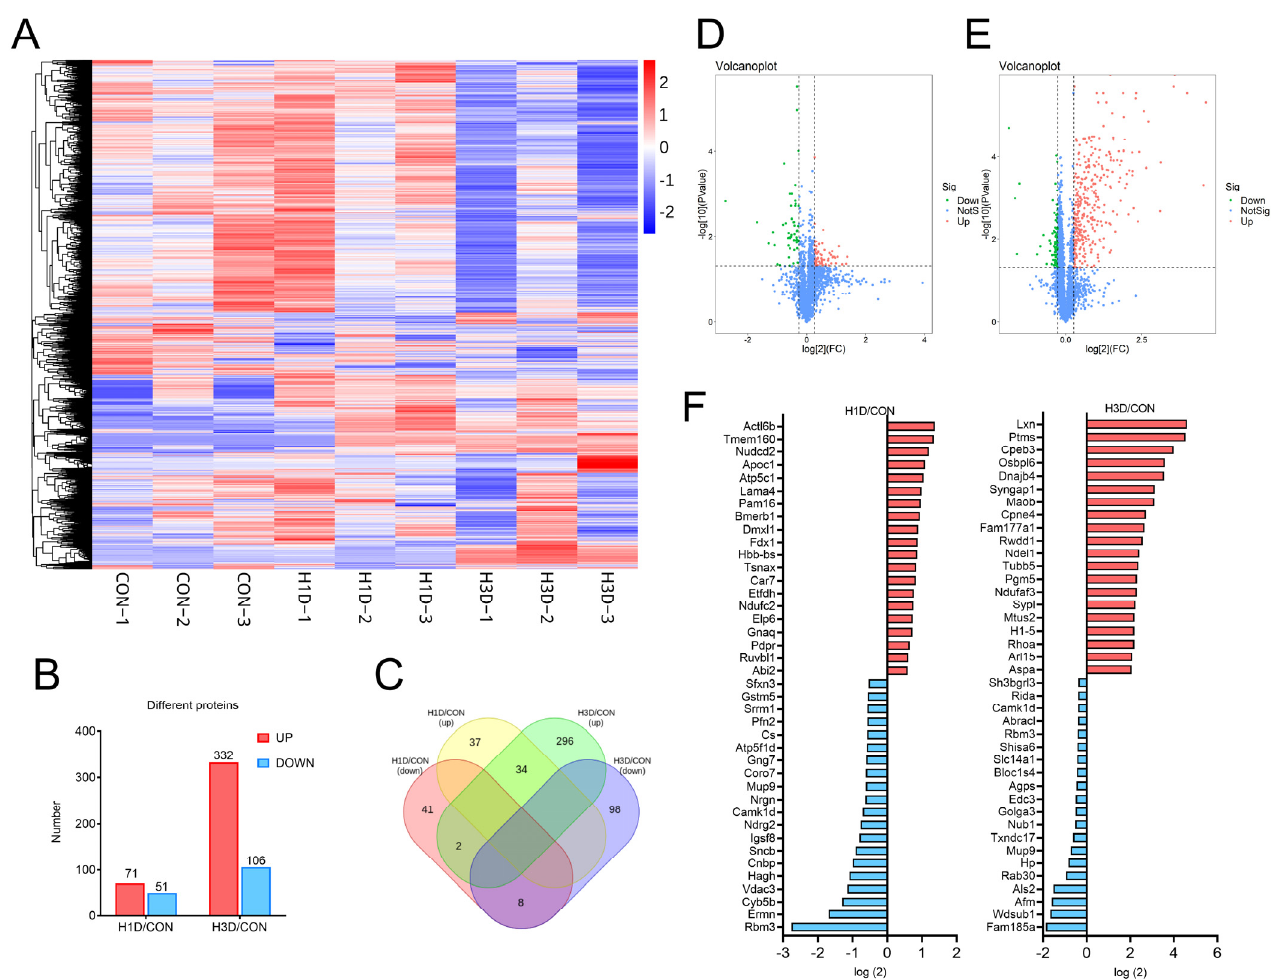
Figure 2. Global proteomic signatures of the hippocampus under hypoxic stress. ( A ) Heat map presenting a respective characteristic concentration profile. ( B ) The proteins were considered signifi- cantly regulated at p ≤ 0.05 and a fold change (FC) ≥ 1.2 or ≤ 0.67. ( C ) Venn diagram of the identified significantly regulated proteins with different time duration exposures to hypoxia. ( D , E ) Volcano map showing the expression of proteins with significant differences more intuitively. ( F ) Top 20 proteins with the most prominent differences between H1D or H3D mice and CON mice. The red represents upregulation, the blue downregulation.